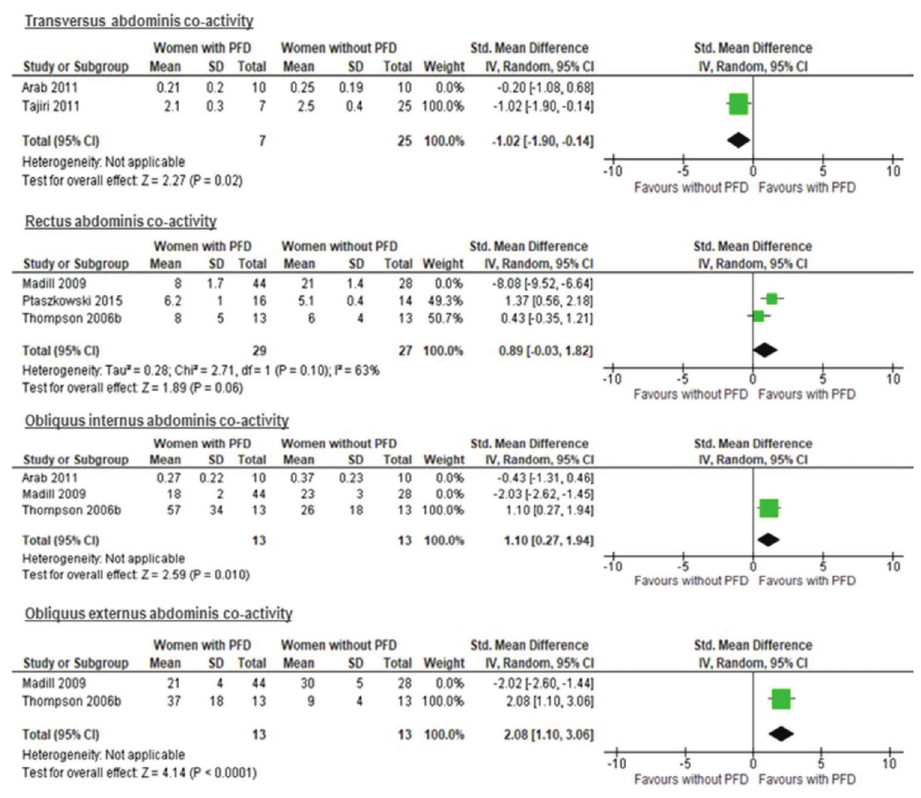
Figure 4 - Sensitivity analysis of co-activity of transversus abdominis (without the Arab et al. 2011 study), rectus abdominis (without the Madill et al. (31)), obliquus internus (without the Madill et al. (31)) and obliquus externus (without the Madill et al. (31)) muscles when the pelvic floor muscles contract. CI = Confidence interval; PFD = Pelvic floor